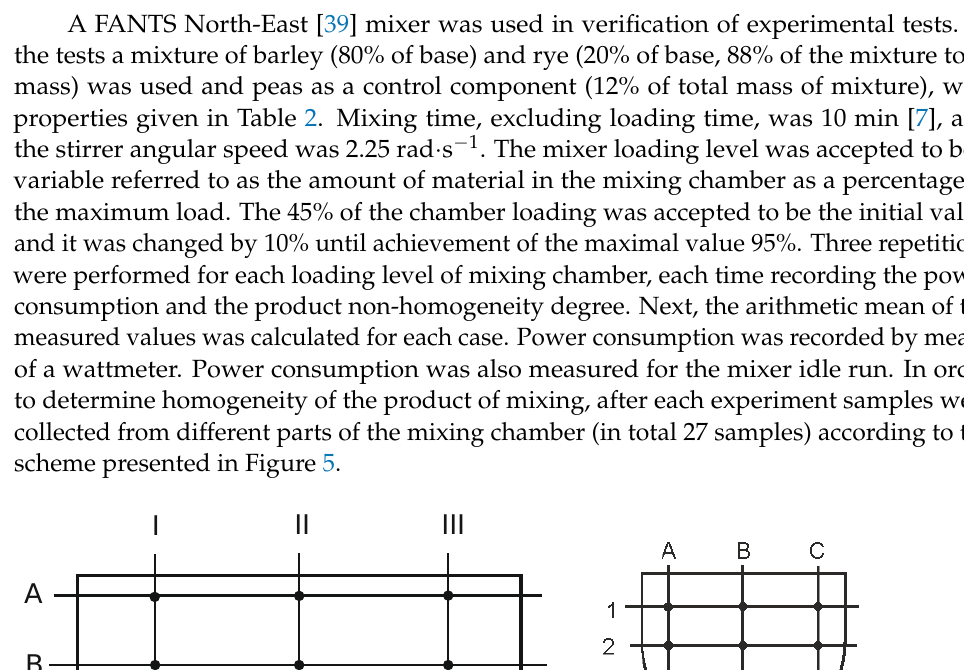
Figure 4. Scheme of the mixing chamber with marked interaction angles φ and central screw radii ρ ; 1—mixing chamber; 2—external screw; 3—middle screw; 4—internal screw; 5—upper material layer of the mixing chamber.